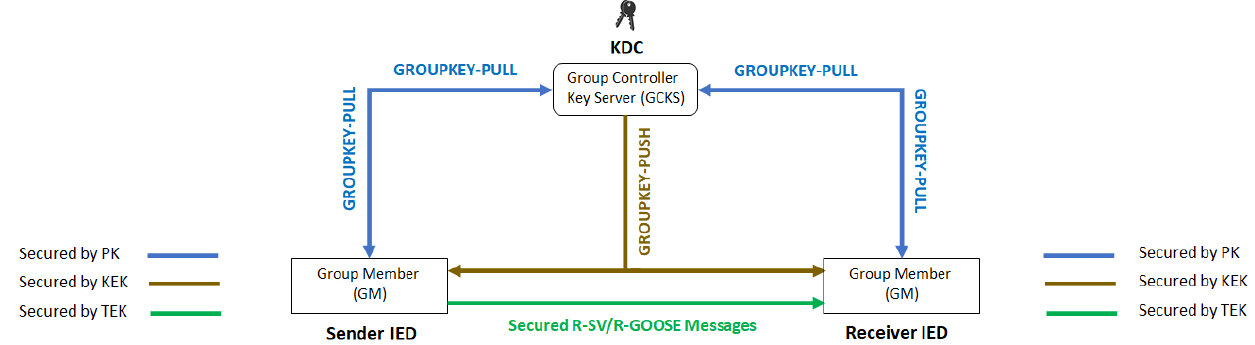
Figure 8. Communication of secured R-SV/R-GOOSE within centralized security architecture.